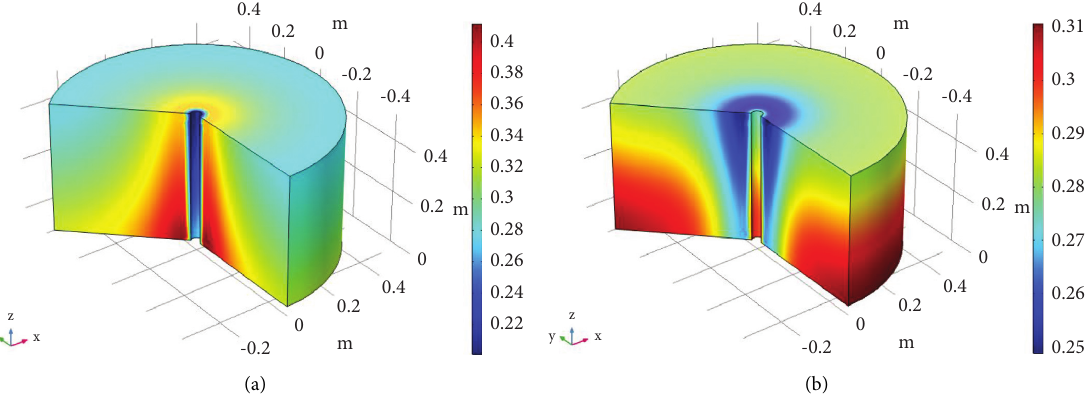
Figure 7: Saturation distribution in the soil: (a) t � 1d during the heating process; (b) t � 5.5d during the cooling